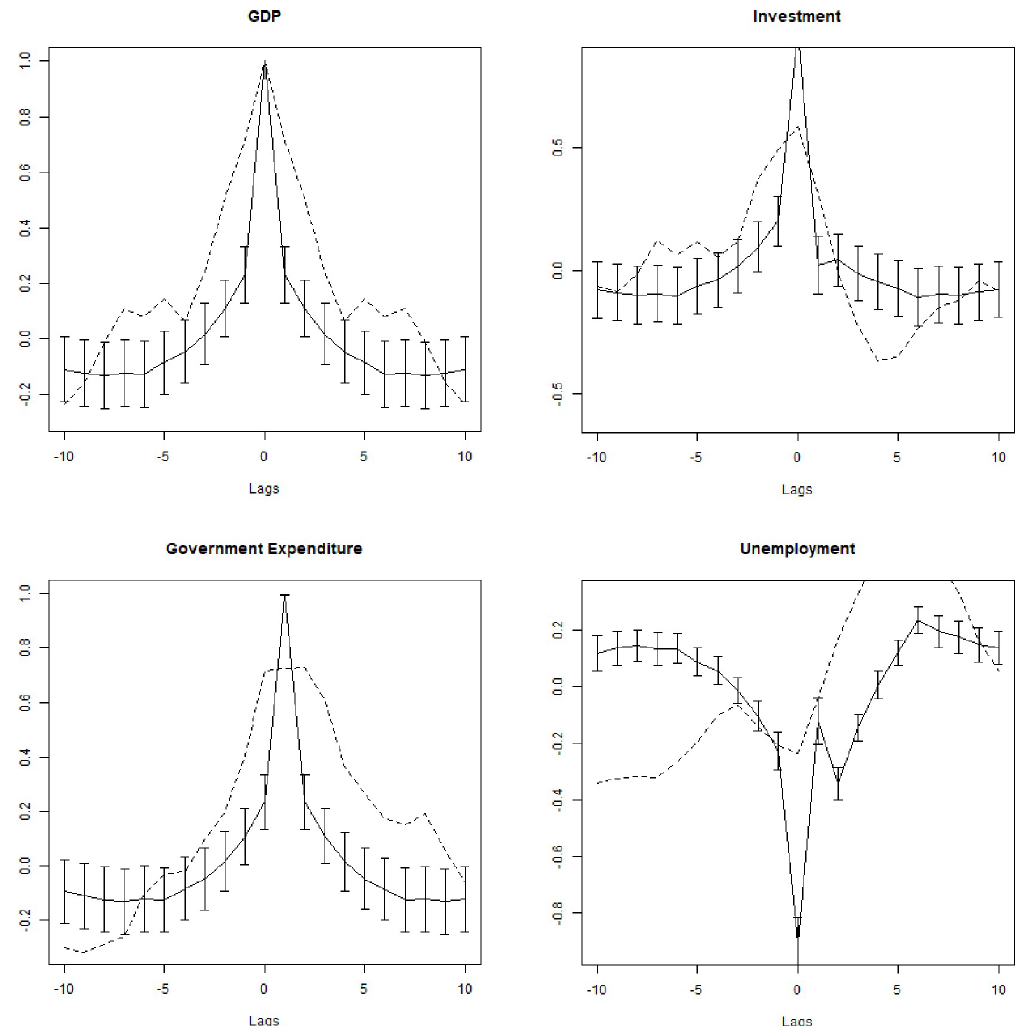
Fig 4. Average artificial (continuous) and real (dashed) cross-correlations of the de-trended series up to the 10 th lag. Bars are standard deviations of Monte Carlo average cross-correlations.